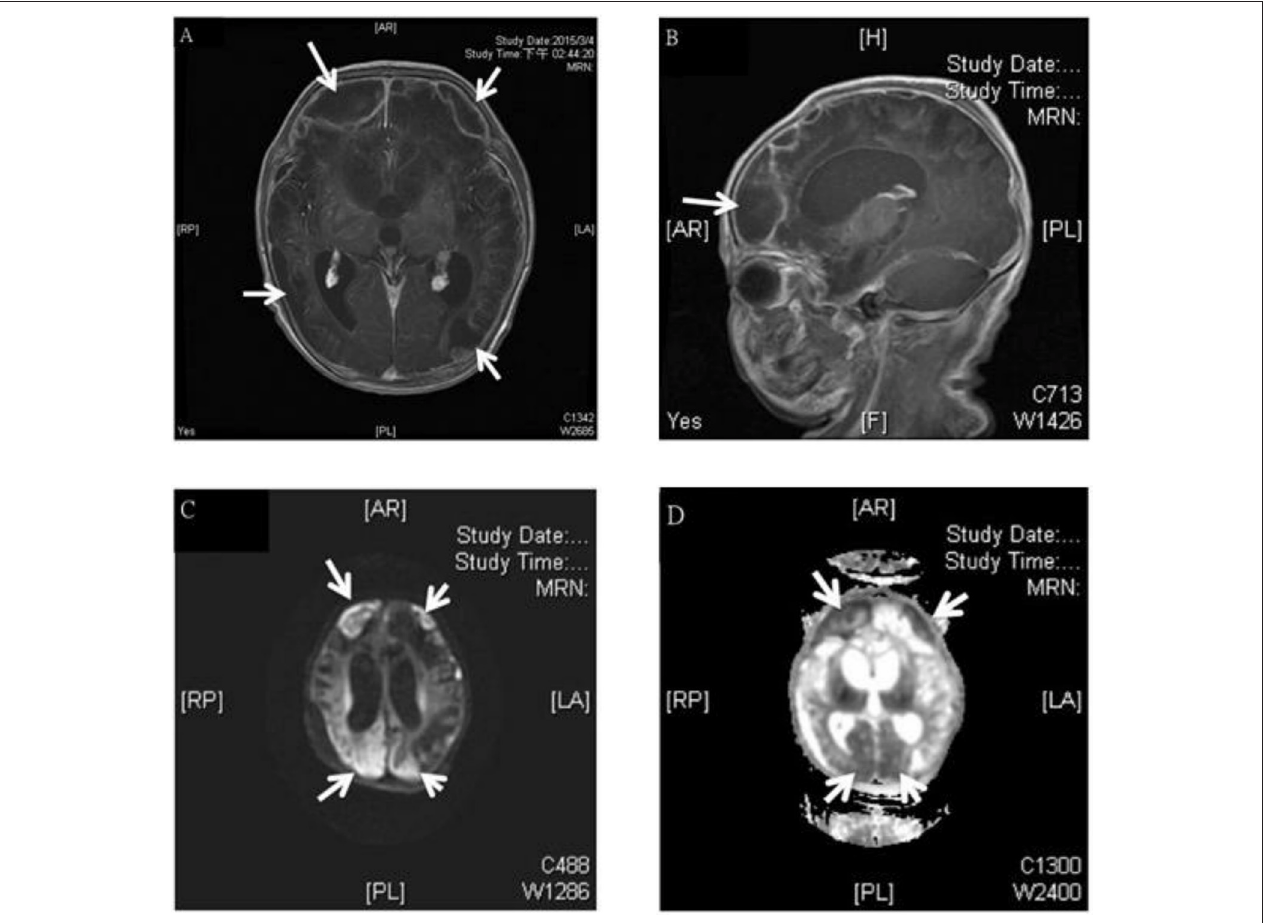
FIGURE 1 | MRI study of a 3 week old boy with GBS subdural empyema. Axial (A) and sagittal (B) T1-weighted gadolinium-enhanced MRI showed subdural empyema over bilateral frontal, parietal, occipital area (arrows); diffusion-weighted (C), and apparent diffusion coefficient (D) -weighted MRI of a subdural empyema over bilateral frontal, parietal, occipital area